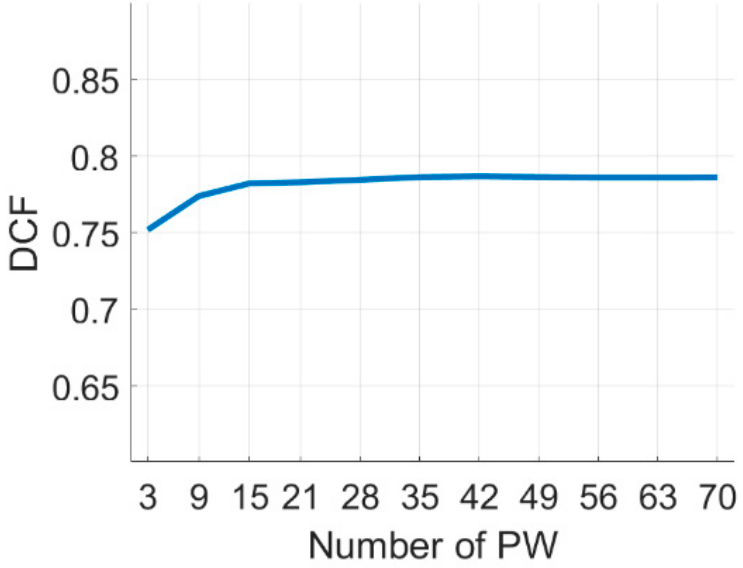
Figure 5. Plot of DCF value in Tx-DMAS method as a function of number of PW.